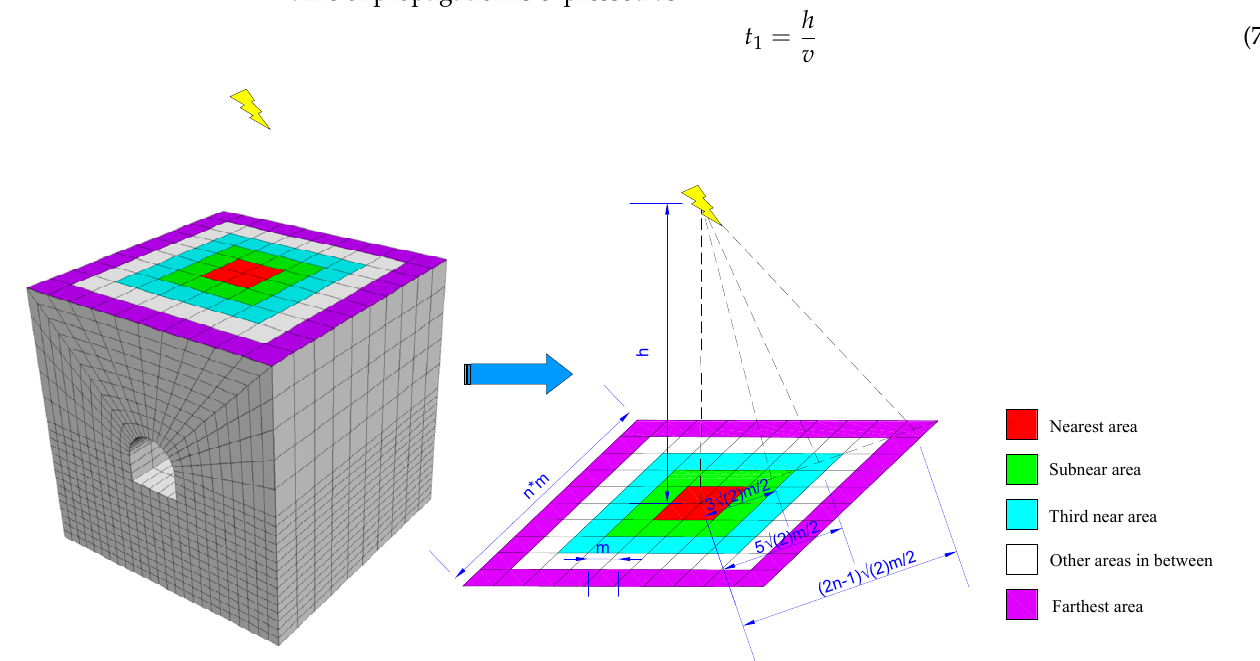
v , then the dynamic load first propagates and arrives at the red area in the figure and the time of propagation is expressed as: